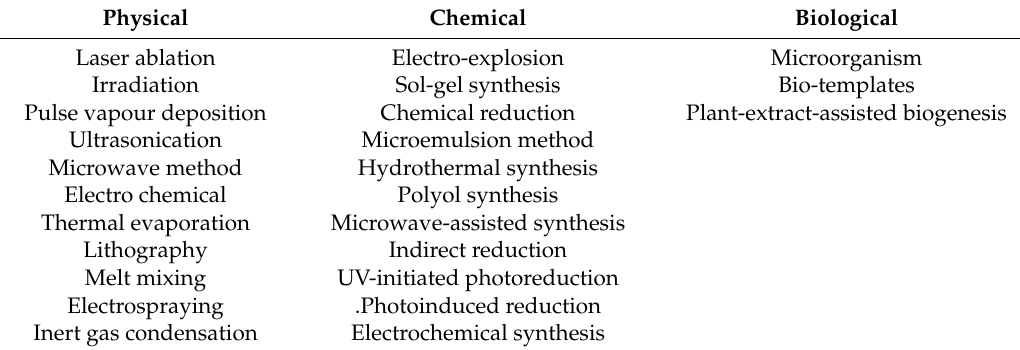
Table 5. The overview of the preparation techniques of AgNPs